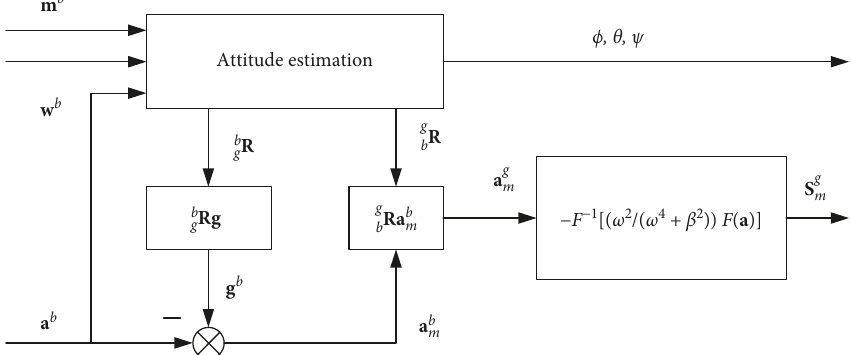
Figure 7: Principle of the vehicle vibration displacement reconstruction